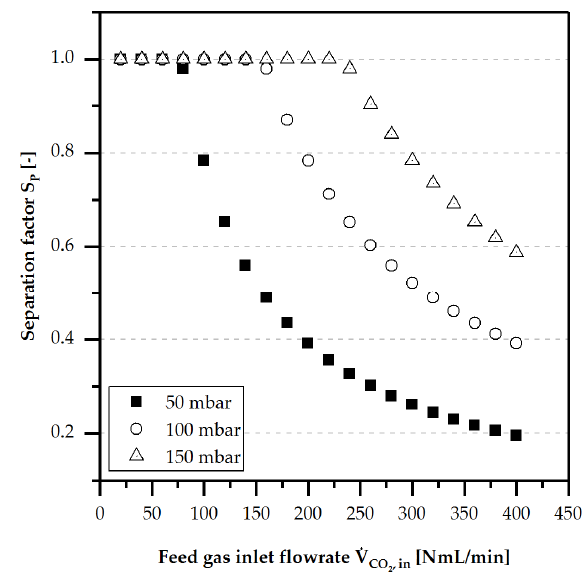
Figure 3. Theoretical S P,i trend according to a maximum separable gas feed amount of 78.3 mL/min, 156.7 mL/min, and 235.0 mL/min calculated by Darcy’s law with κ = 7.8 · 10 − 15 m, A = 114.5 mm, ∆ p = 50 mbar, 100 mbar, and 150 mbar, η = 17.1 µ Pa s, and l = 200 µ TM